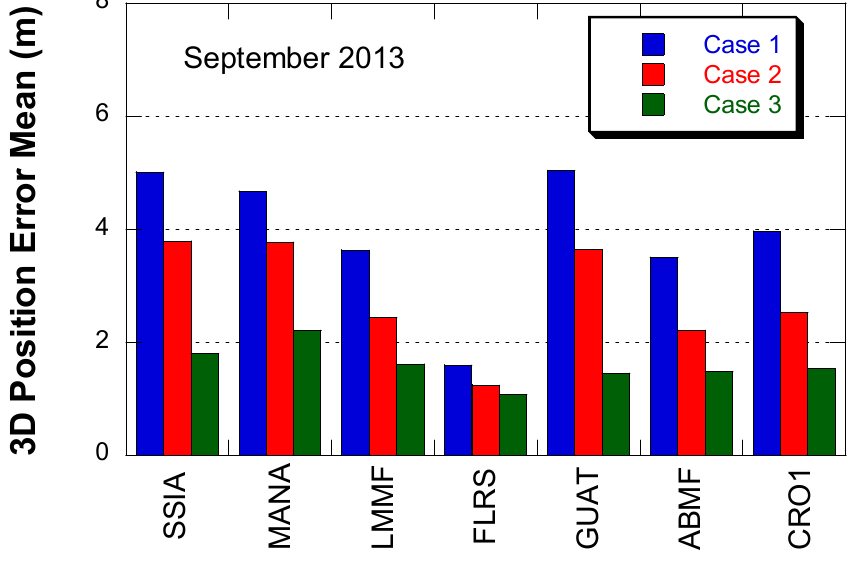
Figure 12. 3D position error mean for different positioning methods at seven IGS stations in Sep- tember 2013.